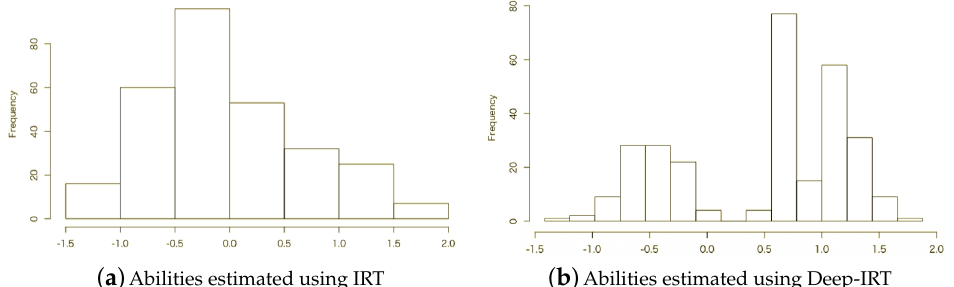
Figure 5. Histograms of abilities estimated using IRT and Deep-IRT for Classi_Biology